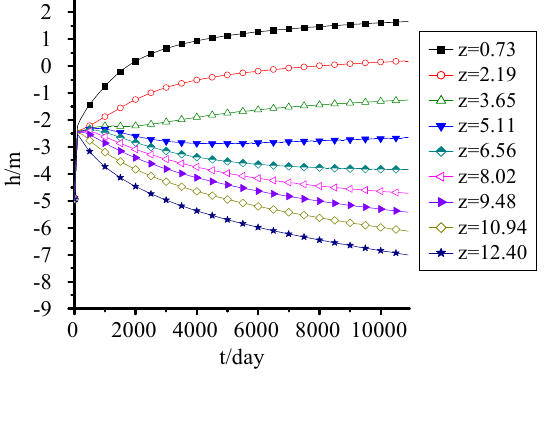
Figure 5. Pressure head change with time.